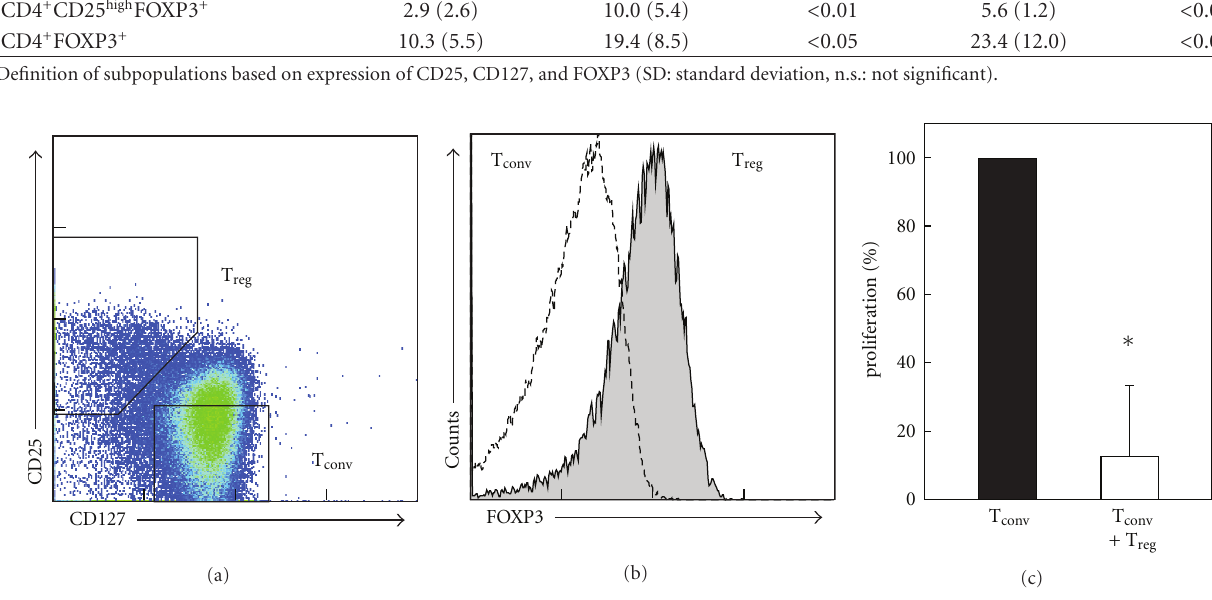
Figure 4: Functional analysis of CD4 + CD127 low CD25 + T reg cells in cancer patients. (a) Sorting strategy for isolating CD4 + CD127 low CD25 + T reg cells (T reg ) as well as conventional CD4 + CD127 + CD25 − T cells (T conv ). (b) Expression of FOXP3 in the corresponding T-cell populations. (c) Percentage of proliferation of CD4 + CD25 − CD127 + T conv cells (black bar) alone or cultivated with CD4 + CD127 low CD25 + T reg cells derived from CRC patients ( n = 4) at a 1:1 ratio (white bar) both in the presence of CD3/CD28 mAb coated beads. Error bars represent standard deviation ( ∗ , P < 0 . 05, Student’s t